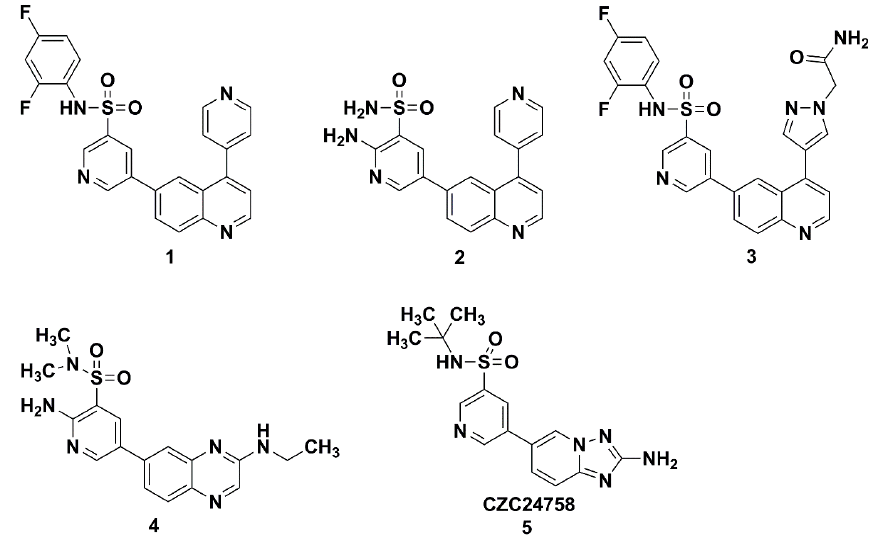
Figure 1. Structures of pyridine-3-sulfonamide derivatives of PI3K inhibitor.